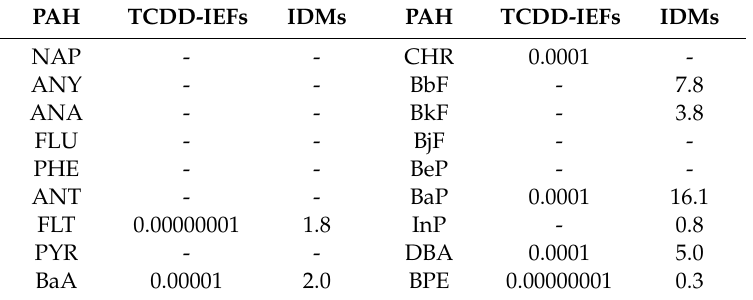
Table 2. The average 2,3,7,8-tetrachlorodibenzo- p -dioxin-induction equivalency factors (TCDD-IEFs) and indirect-acting mutagenicities (IDMs) in S. typhimurium TA100 strain with S9 mix (rev. / ng) for each PAH.